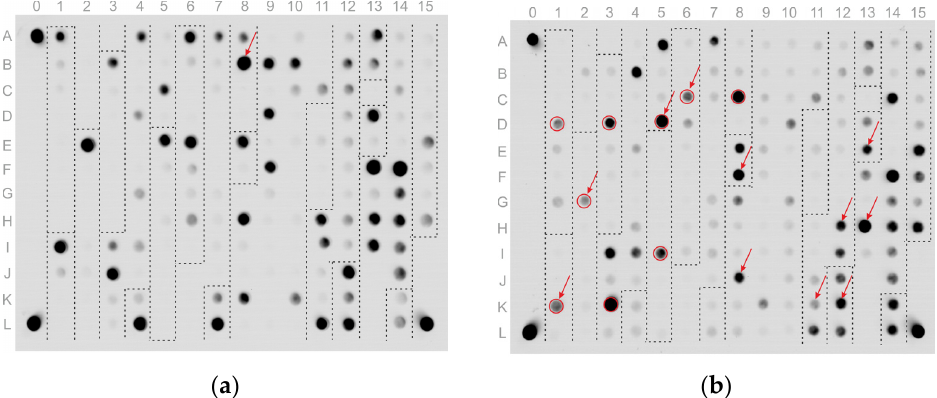
Figure 3. Fluorescence hybridization patterns of microarrays after analysis of DNA from N. gonorrhoeae isolates. Groups of elements (as denoted in Figure 1) are highlighted by dashed lines. Elements with detected mutations are noted with arrows, and elements with detected mosaic penA alleles are circled in red. ( a ) Isolate carrying the non-mosaic penA gene encoding PBP2 with the insertion of Asp at position 345. ( b ) Isolate carrying the mosaic penA gene with different substitutions and multiple mutations in the ponA, porB, gyrA, parC, rpsJ , and mtrR (promoter region) genes.